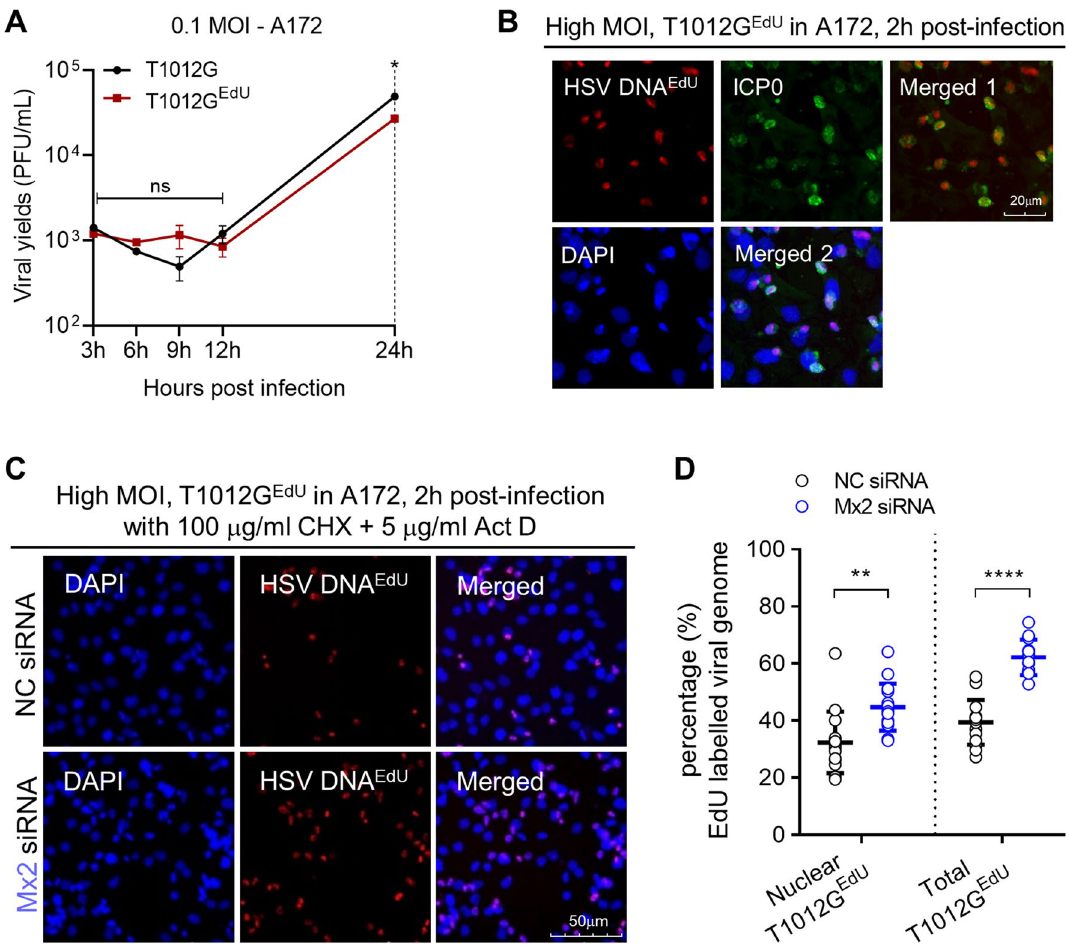
Figure 3. Effects of Mx2 depletion on nuclear translocation of oHSV-1 viral genome in A172 cells. ( A ) The growth curve of EdU-labeled oHSV-1 T1012G (T1012G EdU ) from A172 cells. Virus progeny were harvested at the indicated time and titrated in Vero cells. ( B ) The infection of T1012G EdU in A172 cells was assessed by immunofluorescence assay. Viral genomic DNA EdU (red), ICP0 (green), DAPI (blue) as visualized. ( C ) Nuclear import of EdU-labeled viral genomic DNA in Mx2-depleted A172 cells. Mx2-depleted or mock-depleted A172 cells were infected with high MOI of EdU-labeled T1012G virus for 2 h. Viral genomic DNA EdU (red), ICP0 (green), DAPI (blue) were immune-stained as indicated. Samples were analyzed with the microscope at magnification, ×20. Scale bar, 50 mm. ( D ) Percentage of EdU labeled viral genomes coinciding with the nuclear mask. 15 fields were randomly chosen from the samples. Numbers of cell and EdU-labeled dot were counted in merged (DNA EdU + DAPI) images. Percentage = numbers of EdU dots (nuclear or total)/numbers of cell in each field. (** p < 0.01; compared with NC siRNA-treated A172 cells. Error bars represent